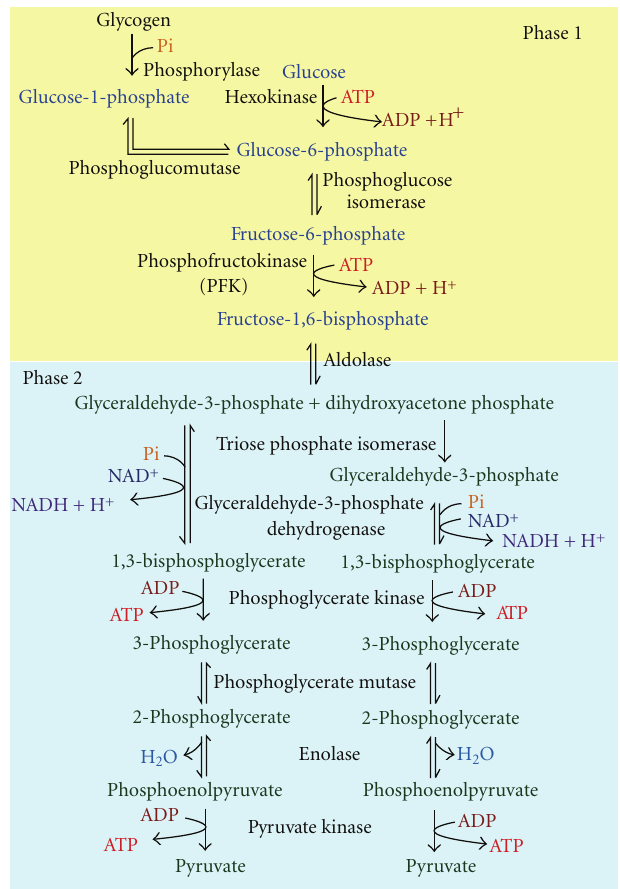
Figure 8: The glycolytic pathway. Note the duplication of phase 2 3-carbon metabolite reactions to account for the 6 carbons of each metabolite from phase